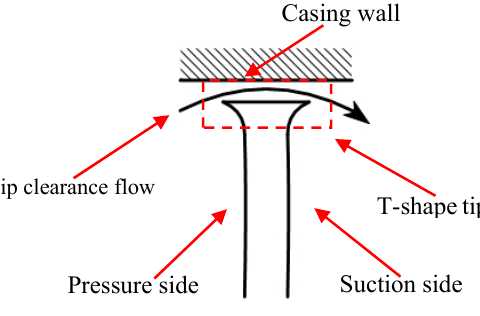
Figure 33. Sketch of T-shape blade tip [81].